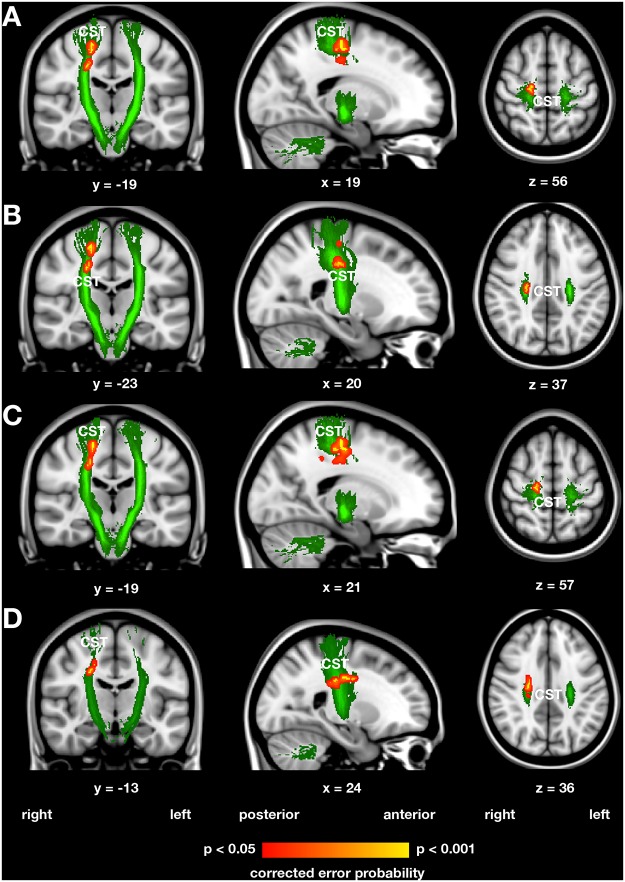
Increased fractional anisotropy and axial diffusivity in the right corticospinal tract of handball players derived from the tract-based spatial statistics group analysis (A and B) and correlation analysis (C and D).The statistical parametric maps (shown in red yellow) were height-thresholded at p < 0.05 corrected for multiple comparisons using permutation-based non-parametric testing across space (FSL’s randomise tool, 5000 permutations). Increased fractional anisotropy (FA) was evident in the corticospinal tract (CST) immediately inferior to the right premotor and primary motor region (Fig 2A) and approximately on the level of the corpus callosum (Fig 2B). The analysis of axial diffusivity revealed that increased FA in the CST of handball players (Figs 2A and 2B) is mainly driven by increased axial diffusivity (Fig 2C). Years of handball training experience were inversely associated with radial diffusivity in a cluster located in the right CST on the height of the corpus callosum (Fig 2D). The corpus callosum is not shown because the finding in that structure was only significant at a trend level towards statistical significance. The regions of interest, here the left and right CST, subjected to the statistical analysis are shown in graded green. x, y, z represent coordinates of the Montreal neurological institute (MNI) stereotactic space.